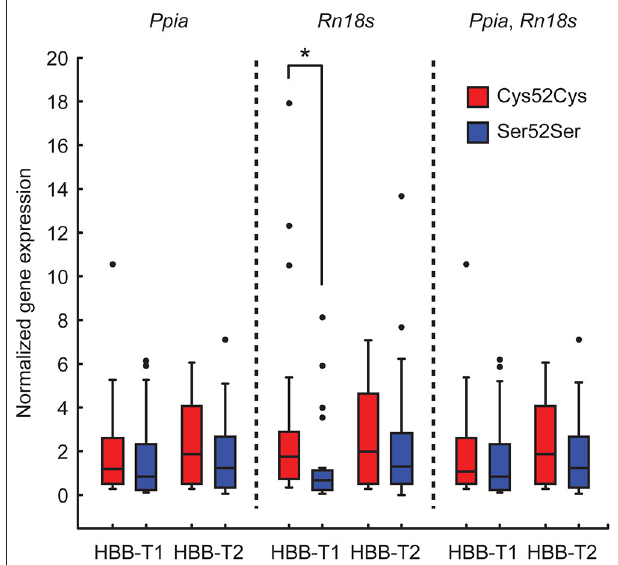
FIGURE 1 | Box plot representation of gene expression normalized to two reference genes ( Ppia and Rn18s ) and their mean. * P < 0.05 (Kruskal-Wallis